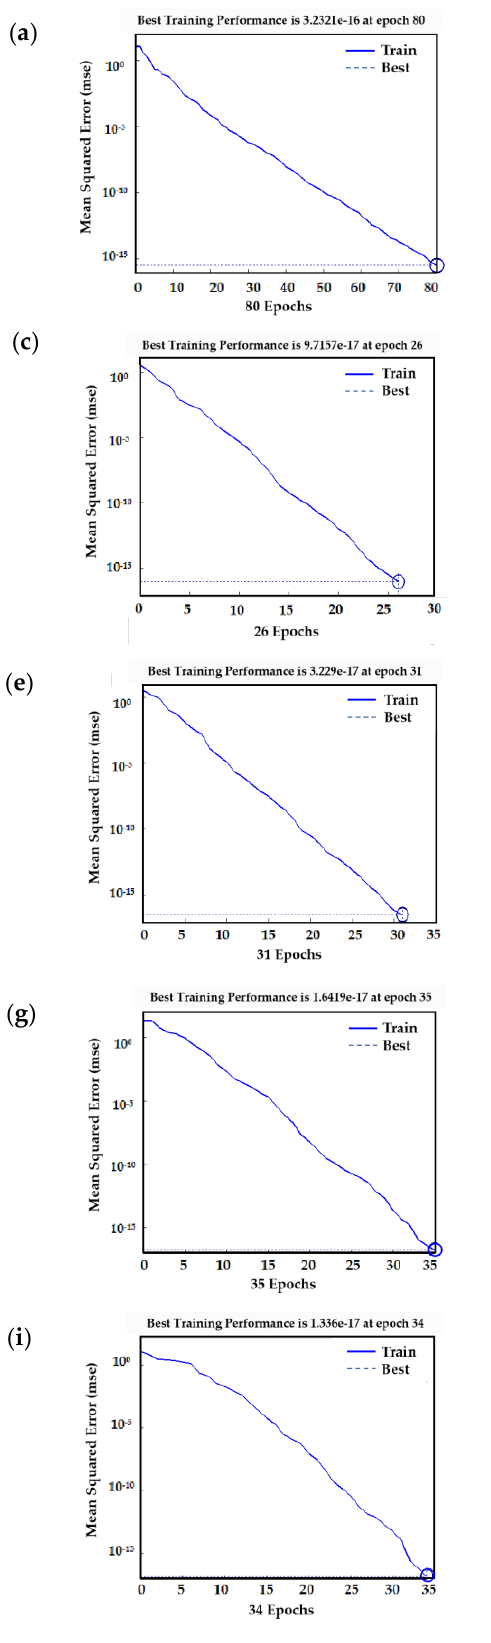
Figure 15. Ten single-parameter neural network training performance results: ( a ) rise time; ( b ) count; ( c ) energy; ( d ) duration; ( e ) amplitude; ( f ) RMS; ( g ) ASL; ( h ) signal strength; ( i ) center frequency; ( j ) peak frequency.